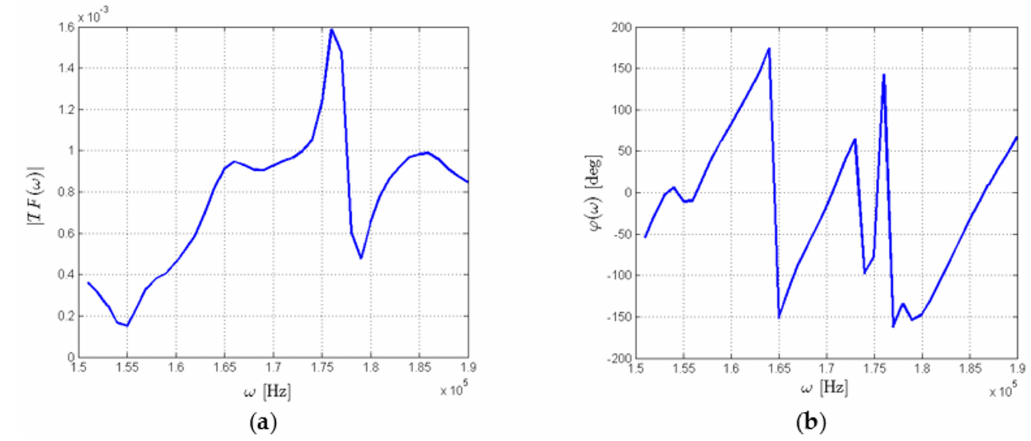
Figure 3. Example of transfer function components: ( a ) amplitude ratio | TF ( ω ) | ; ( b ) phase difference ϕ ( ω ) , between output and input